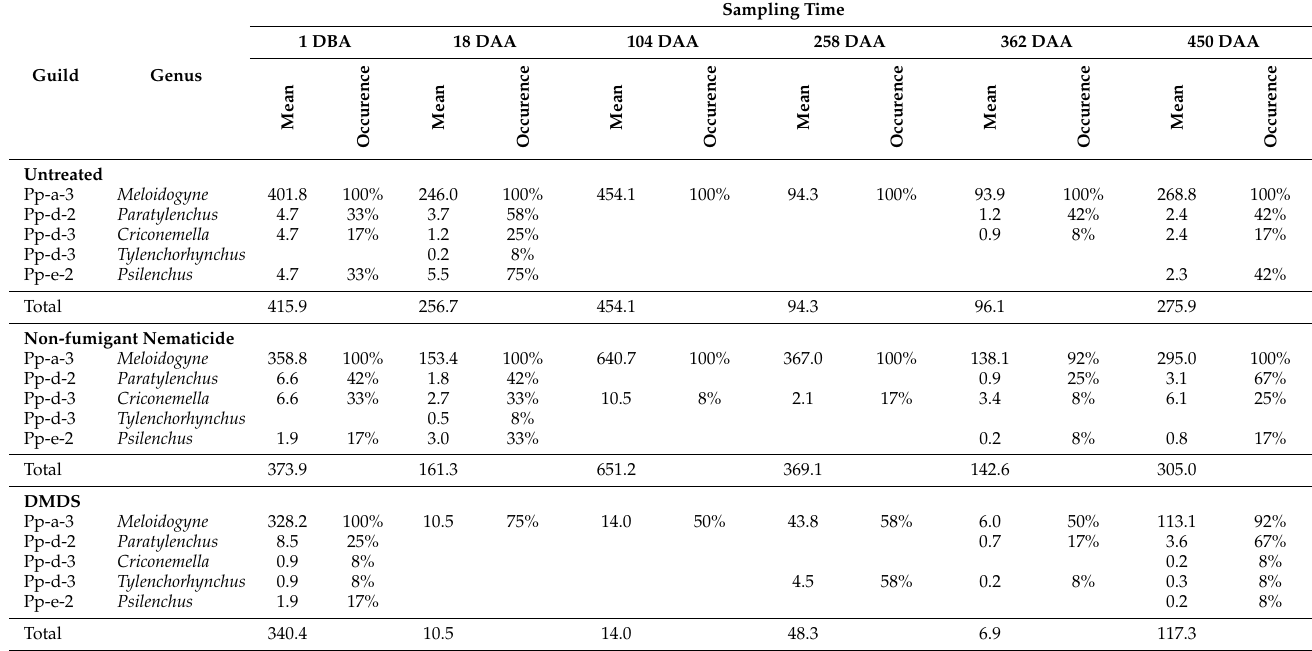
Table A1. Structure, abundance and occurrence of plant-parasitic nematodes in trial variants during the study period.